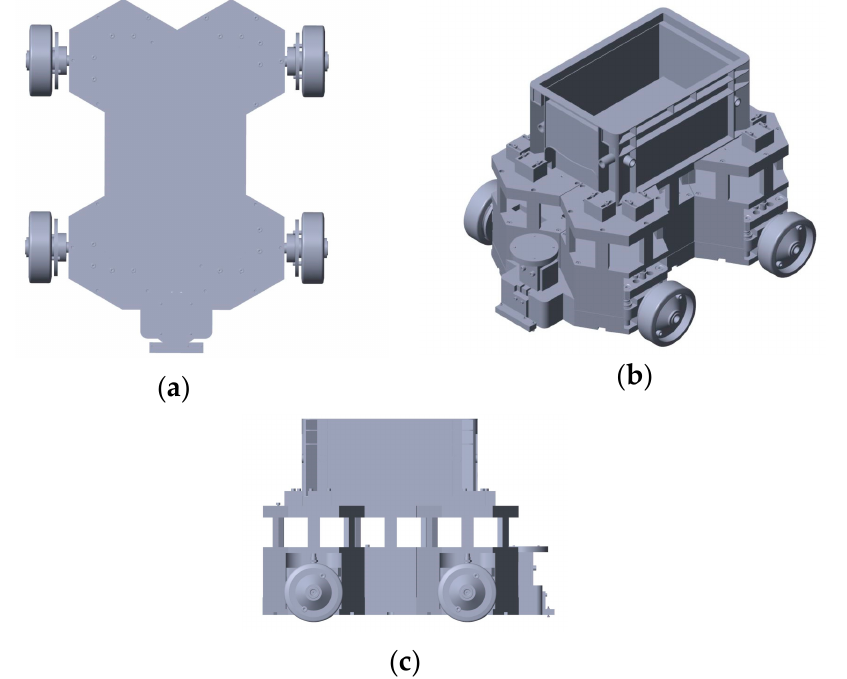
Figure 23. Result of the CAD model import in Simulink Simscape.